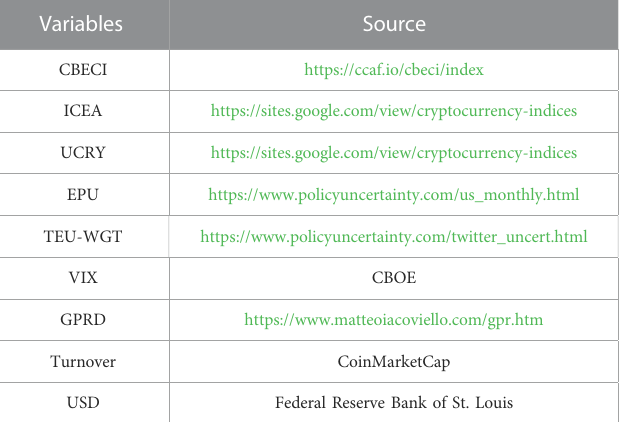
TABLE A2 Sources of potential drivers.